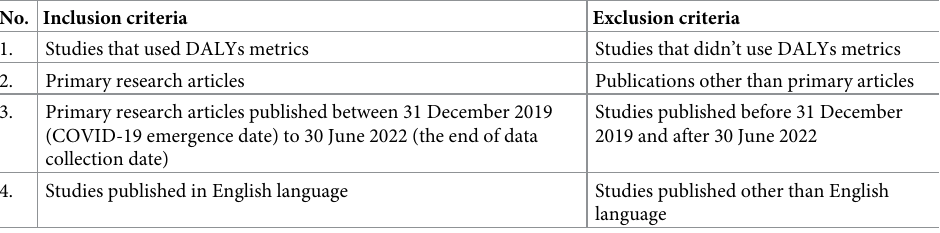
Table 1. Inclusion and exclusion criteria for study